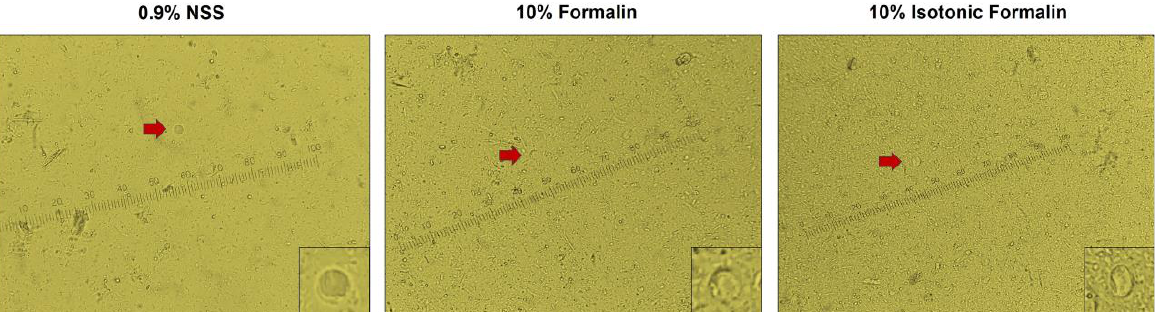
Figure 3. Presence of parasite in the fecal smears. Fecal smears were prepared using different solutions, including 0.9% normal saline solution (NSS) ( left ), 10% formalin ( middle ), and 10% isotonic formalin ( right ). Ova and parasites were observed. One block of scale bar represents 0.25 micrometers. The red arrow indicates the vacuolar form of Blastocystis spp. The lower right corner of each figure displays a zoomed-in image of the vacuolar form.